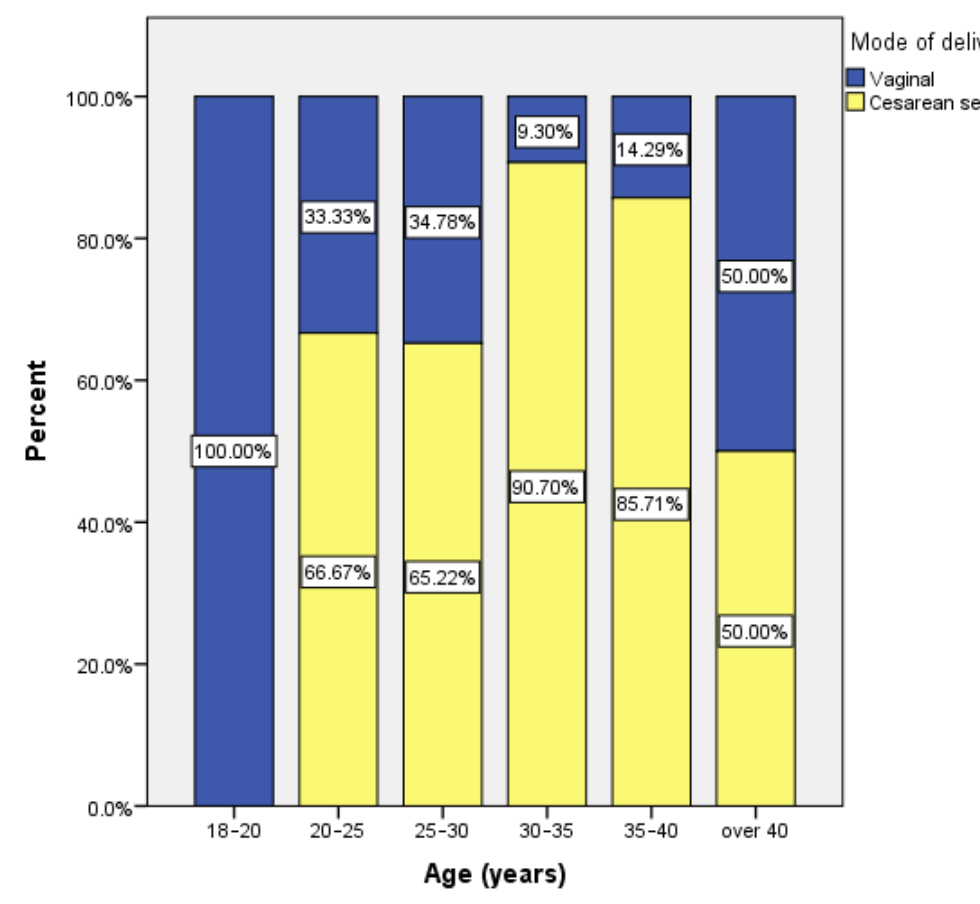
Figure 1. Patient distribution by age and delivery